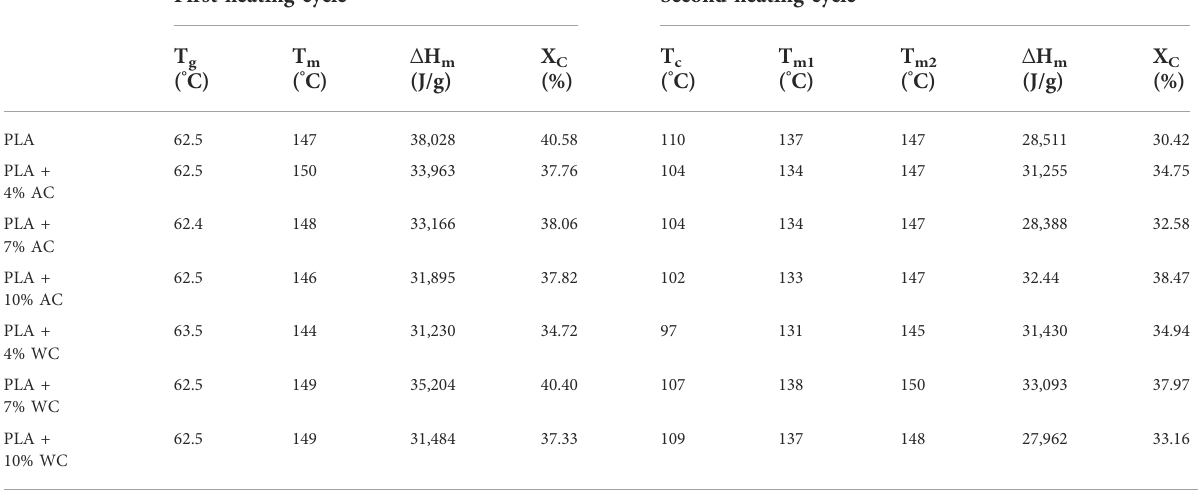
TABLE 3 Thermal properties of PLA, PLA/AC and PLA/WC composites.